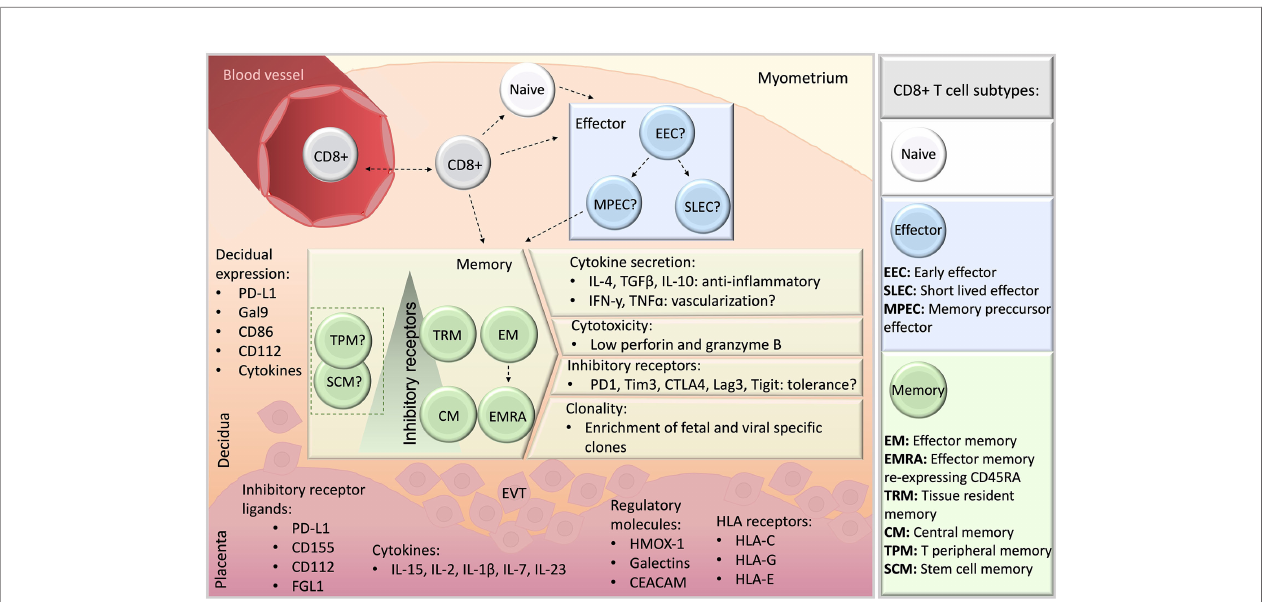
FIGURE 3 | A schematic overview of CD8+ T cells at the feto-maternal interface. CD8+ T cells may migrate from blood (top, left), and whether they differentiate previously or subsequently to seeding in the decidual microenvironment remains unclear (dashed lines). Naive and memory CD8+ T cell populations have been detected in human decidua, whereas information about effector subsets is missing, indicated by a question mark. Among memory populations, TRM, EM, EMRA and CM were reported, and TPM or SCM subsets have not yet been studied. Particular features of decidual memory CD8+ T cells include unique cytokine secretion pro fi le, elevated expression of inhibitory receptors, low basal cytotoxicity and the enrichment in clones speci fi c for fetal antigens and viruses. Ligands for inhibitory receptors are expressed both in the decidua stroma (orange) and placenta (pink). EVT, extravillous